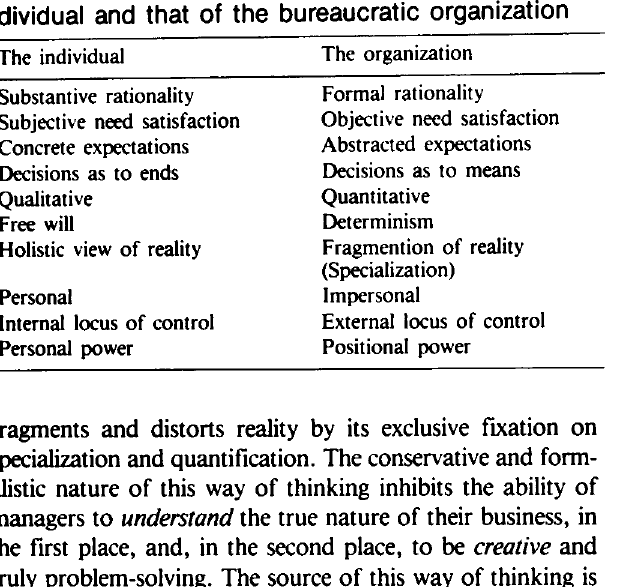
Table 1 Comparison between the nature of the in dividual and that of the bureaucratic